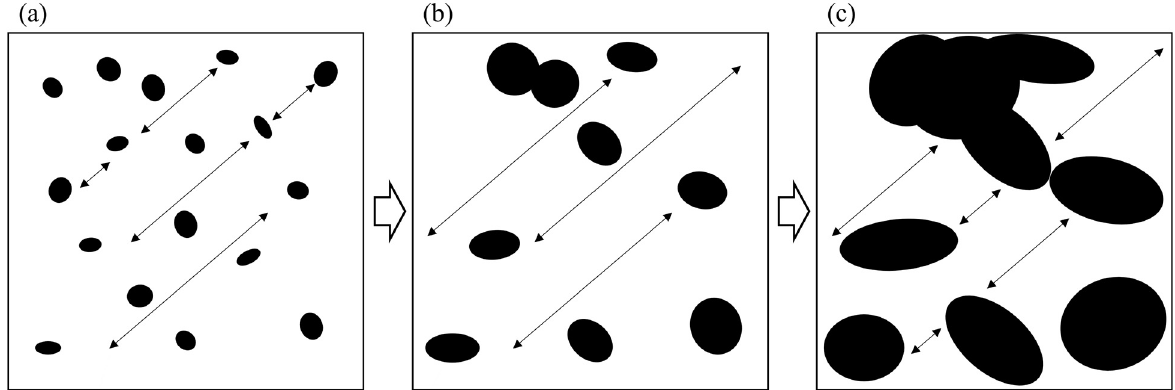
Figure 8. Schematic diagram of changes in intershrub distance (double-headed arrows) with increasing vegetation cover. Shrubs are randomly distributed in a landscape with small shrubs and low vegetation cover ( a ), but their distribution becomes patchy ( b ) as the shrubs grow. When the small cover regime ( a ) shifts to a moderate cover regime ( b ), only some of the shrubs remain because of the spatial heterogeneity of soil nutrients and intra- and interspecific competition among shrubs. As the shrubs continue to grow, the patch size increases ( c ) such that the patches begin to encroach on the intervening bare ground, with the result that the intershrub distance decreases.